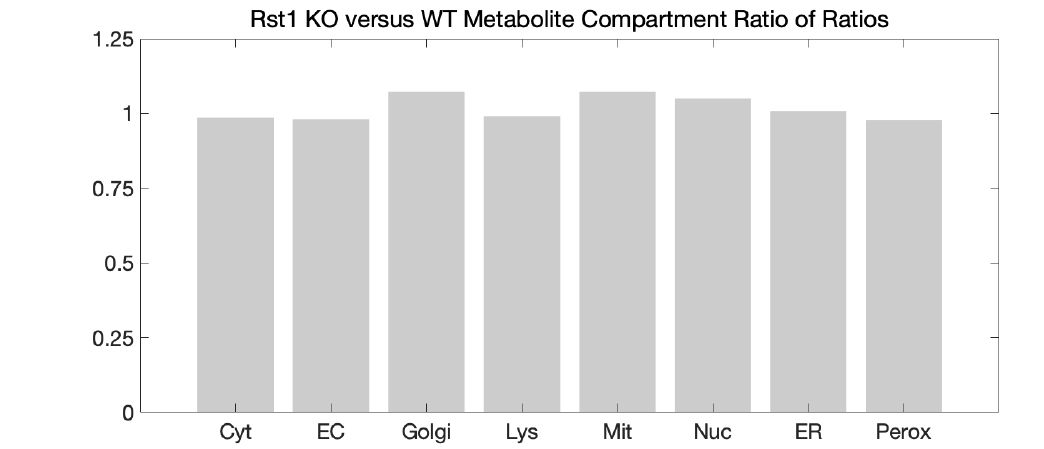
Figure 6. Comparison between WT and Urat1/Rst KO GEMs based upon intracellular compartment size. Ratio between the number of metabolites within each compartment of the Urat1KO versus WT GEMs. There are not significant differences among the metabolomic cohorts in in each model, consis- tent with the differences in metabolite composition of the two network models. Abbreviations are as follows: Cyt-cytoplasm, EC-extracellular, Golgi-Golgi apparatus, Lys-lysosome, Mit-mitochondria, Nuc-nucleus, ER-endoplasmic reticulum, Perox-peroxisome.